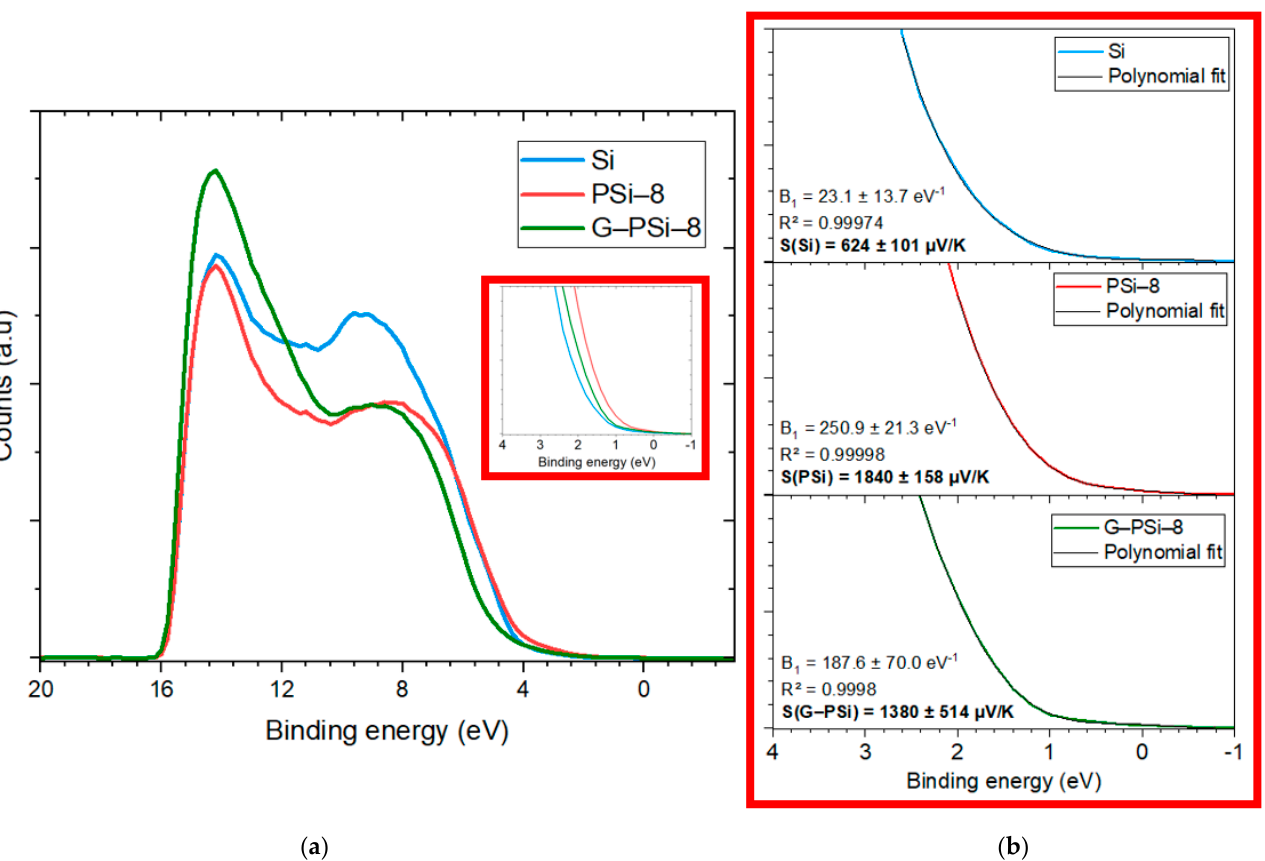
Figure 7. ( a ) UPS spectra of Si, PSi-8, and G-PSi-8; ( b ) zoom on lower binding energy (E B ): E B equal to 0 represents the Fermi level.